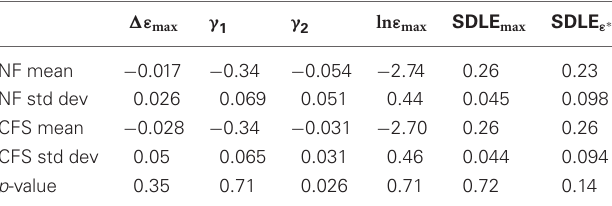
Table 3 | Statistical tests on SDLE parameters during the